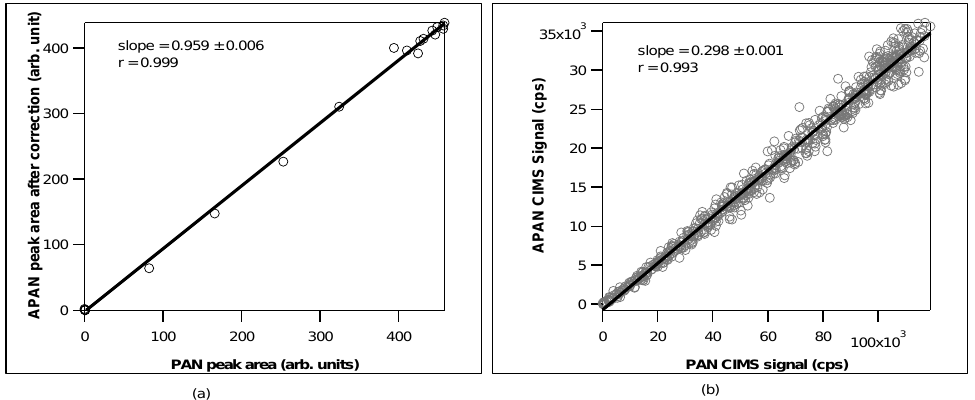
Fig. 9. APAN to PAN ratio as measured with the NCAR fast GC (a) and the TD-CIMS (b) respectively. The TD-CIMS response factor for APAN was computed by comparing these two ratios. Other PAN species response factors were determined in the same way.